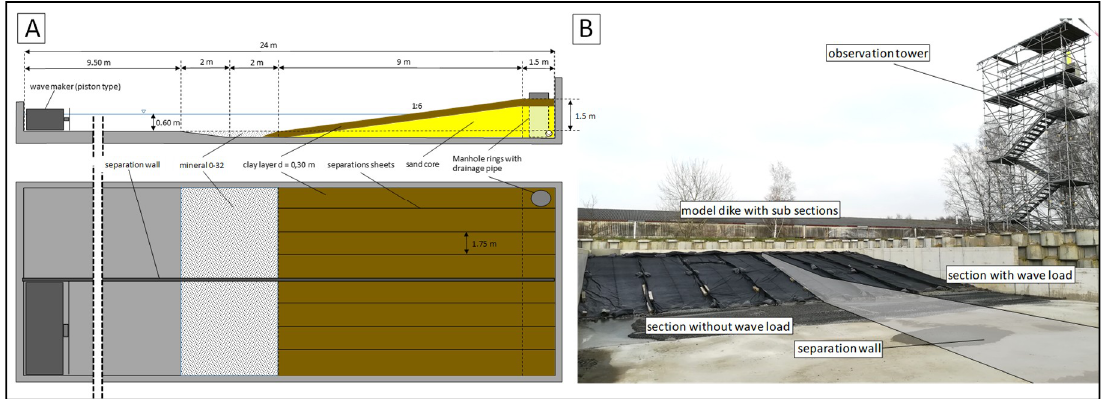
Figure 4. Model setup for the Ecodike project ( A ) and constructed model dike with two sections containing four subsections covered by protection-sheet during the winter months in February 2018 ( B ).